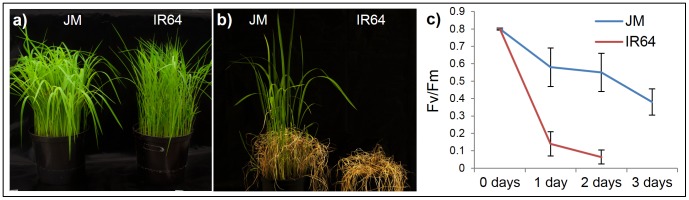
Cold stress survival in Jumli Marshi (JM) and IR64. Jumli Marshi (JM) and IR64 seedlings were grown for three weeks under regular growth conditions (see Materials and Methods) and then moved to +4°C (cold conditions).After three days in cold conditions, plants were moved back to regular growth conditions and allowed to recover for two weeks. (a) Plants just before cold exposure; (b) Cold treated plants after recovery for two weeks; JM, left; IR64, right; (c) Chlorophyll fluorescence in JM and IR64 undergoing cold stress.